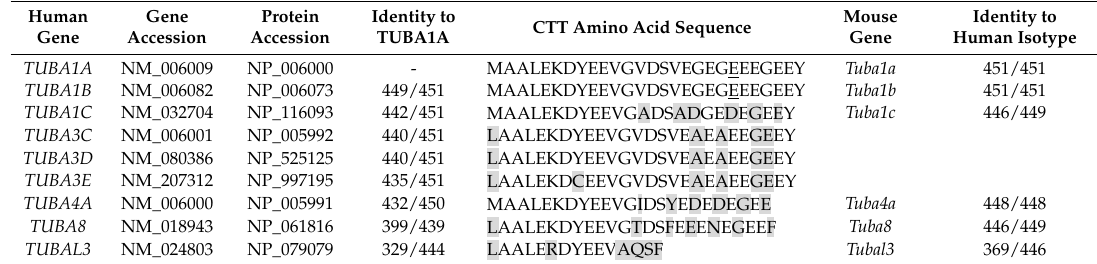
Table 2. Isotypes of α